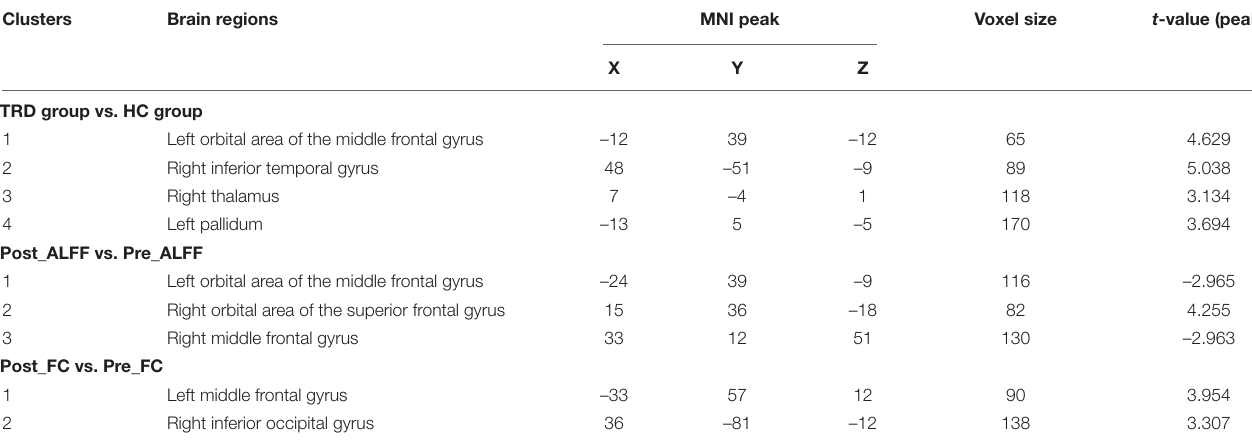
TABLE 2 | Differences in ALFF between the TRD and HC groups; changes in ALFF and FC after taVNS treatment in the TRD group.